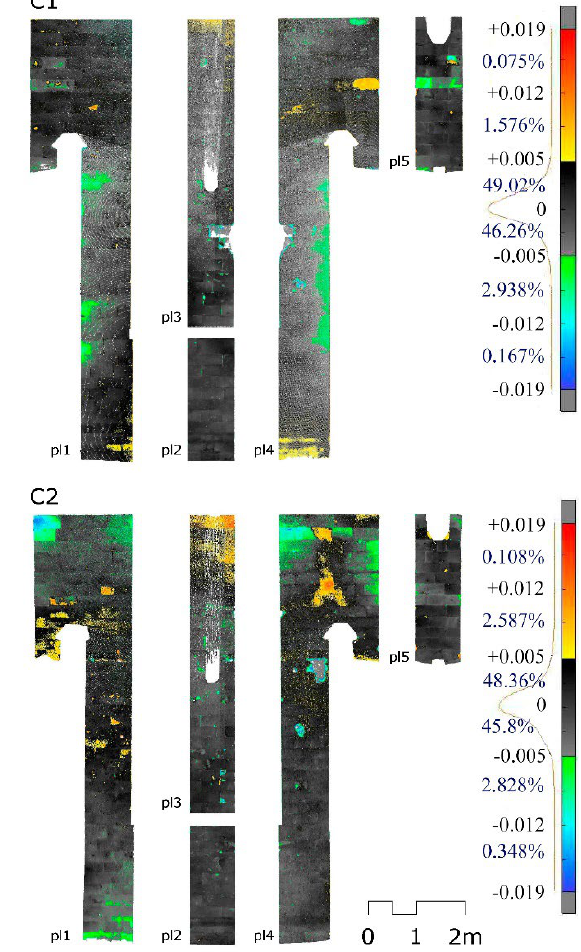
Figure 12: Flatness study of the walls of the lower